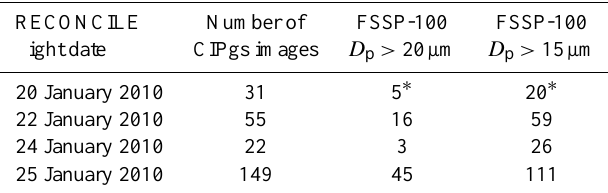
∗ For the flight on 20 January 2010, the data of FSSP-300 were taken and scaled to the FSSP-100’s sample